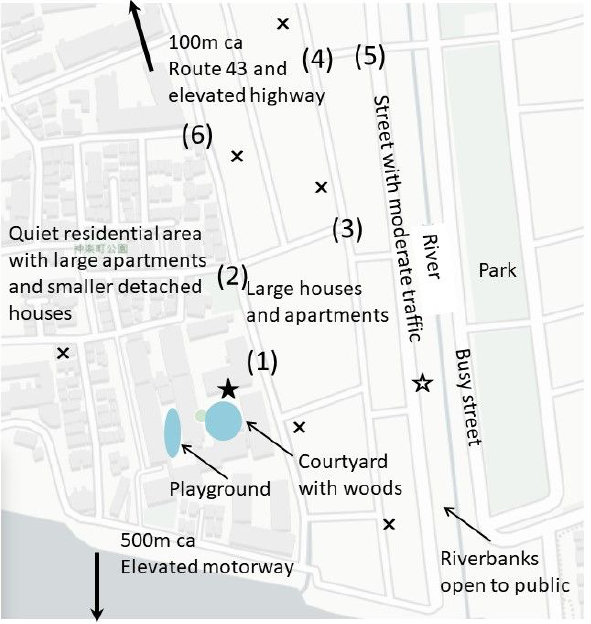
Figure 1: Map of the surveyed area (eastern edge of Kobe). The num- bers (1) to (6) show measuring points in the previous survey [8]. The black star is the measuring point for fixed-point observations in both the present and previous studies. The white star is the measur- ing point for monitoring noise levels in a public space (riverbank). during the June survey reported herein).